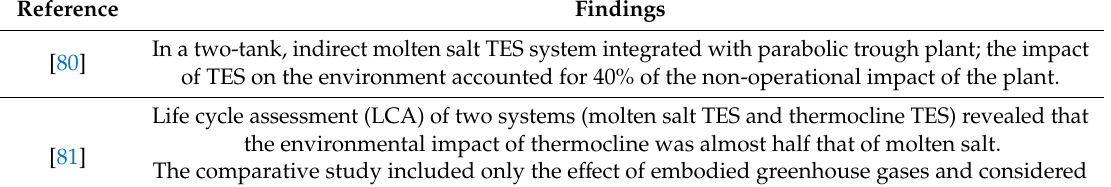
Figure 4. Comparison of the three power plants using the single score indicator [78]. (Reprint with permission [78]; 2019, Elsevier.) Table 5. Summary of the CSP and TES life cycle assessment studies in CSP technologies.